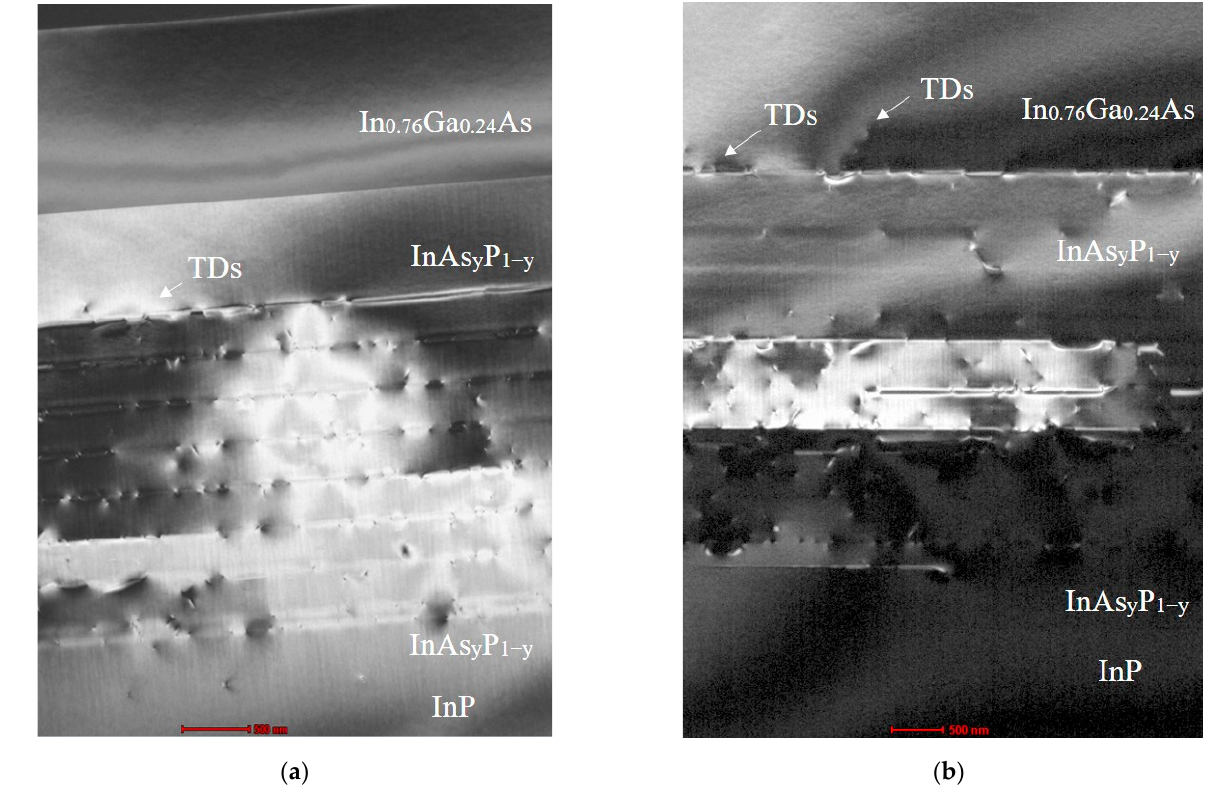
Figure 4. Cross-sectional TEM images of extended wavelength InGaAs on InP substrate: ( a ) sample A and ( b ) sample B.